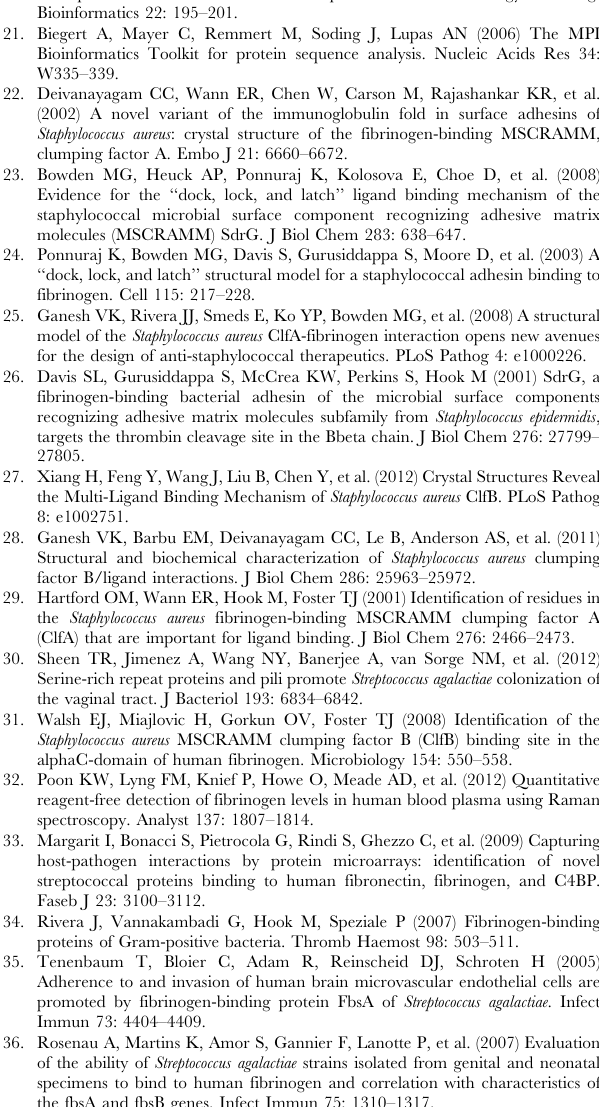
Table S1 Bacterial strains.